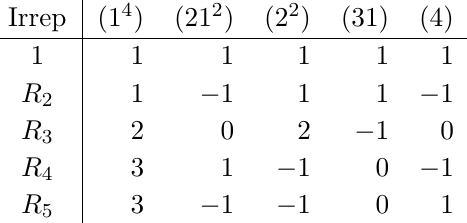
Table 3 . Character table of S 4 , from [53, table 4.5]. Conjugacy classes are indicated by the number of elements exchanged. For example, a “ 1 ” indicates that an element is mapped to itself, whereas a “ 4 ” indicates that all four elements are permuted, for example 1 7→ 2 7→ 3 7→ 4 . (The fact that this distinguishes conjugacy classes is discussed in e.g. [53, theorem 3.7].) In particular, (1 4 ) is the conjugacy class of the